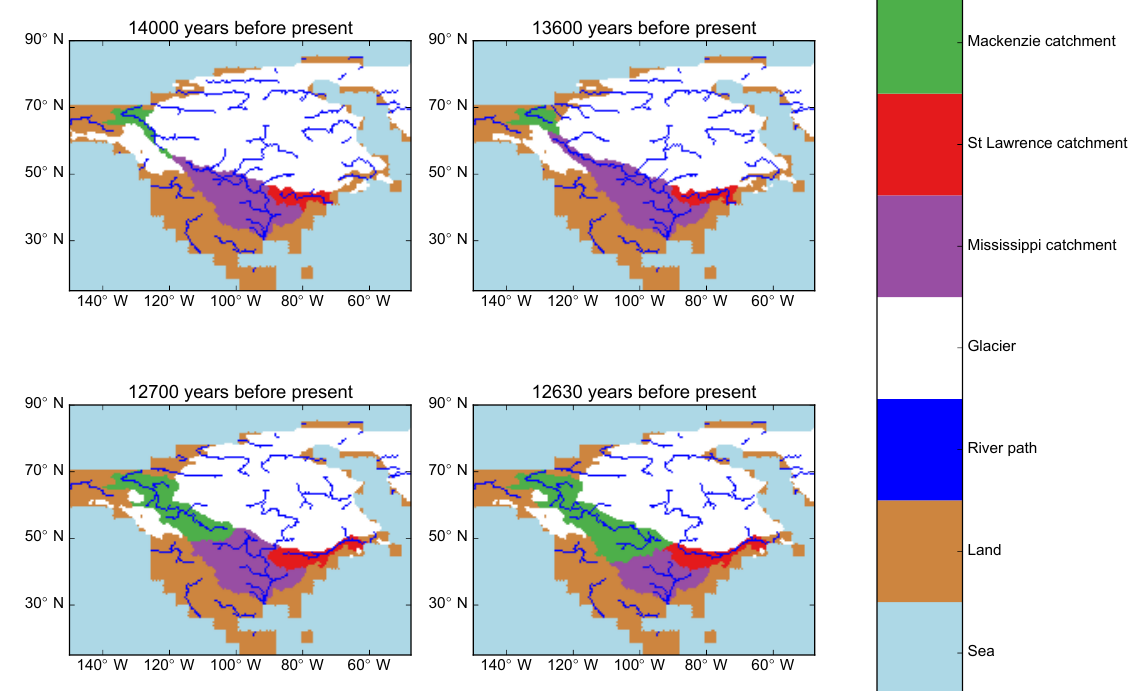
Figure 11. Comparison of rivers generated using the method presented here for four times during the last deglaciation using the ICE-6G_C orography reconstruction. Rivers are shown where the cumulative flow to a given grid cell (on the 0 . 5 ◦ grid) is greater than or equal to 75 cells. The catchments for the Mississippi, St. Lawrence and Mackenzie rivers are marked. Note the diversion of the St. Lawrence to a different mouth point for the two older times. Rivers shown on the surface of ice sheets are topographically defined rivers, and thus their presence does not necessarily imply that there were rivers running off the northern slopes of the Laurentide and Fennoscandian ice